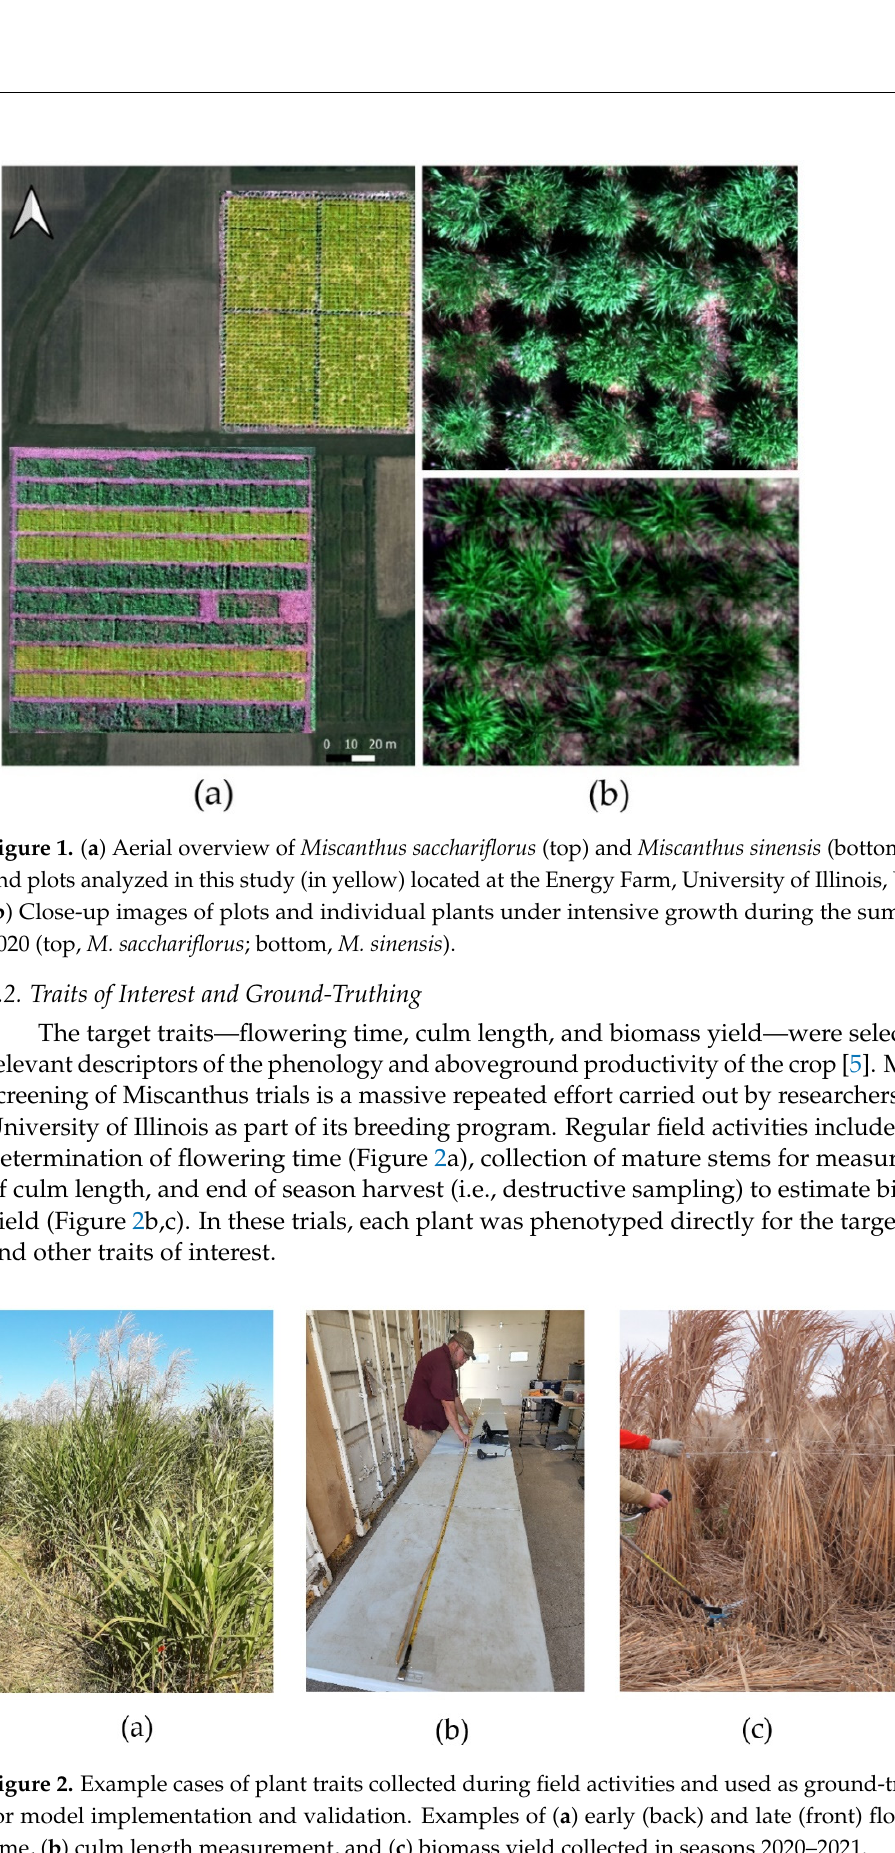
Figure 2. Example cases of plant traits collected during field activities and used as ground-truthing for model implementation and validation. Examples of ( a ) early (back) and late (front) flowering time, ( b ) culm length measurement, and ( c ) biomass yield collected in seasons 2020–2021. In this study, the data collected manually provided the inputs for implementing models based on UAV data. The target traits are described as follows: